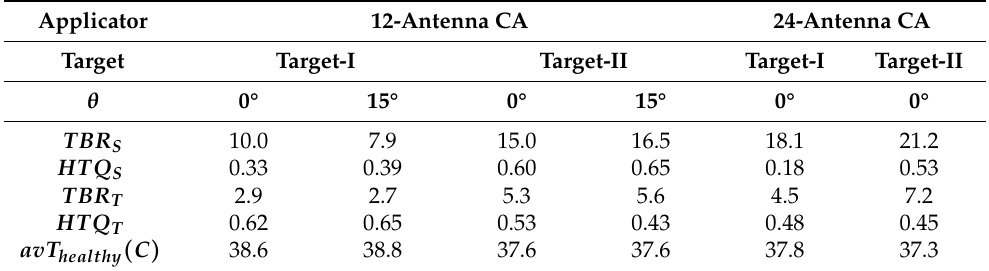
Figure 6. Results of focusing at target-I with the 12-antenna circular MH applicator: ( a , c ) SAR distribution (W/kg) for θ = 0°, 15°. ( b , d ) Temperature distribution (°C) for θ = 0°, 15°. Results of focusing at target-I with the 24-antenna circular MH applicator: ( e ) SAR distribution (W/kg). ( f ) Temperature distribution (°C). The white squares depict the target (inner) and healthy region (outer) boundaries used for the SAR and temperature metric calculations (the axes are in mm). Table 2. Focusing results at two targets of the circular MH applicators with 12 and 24 antennas and changing the rotation